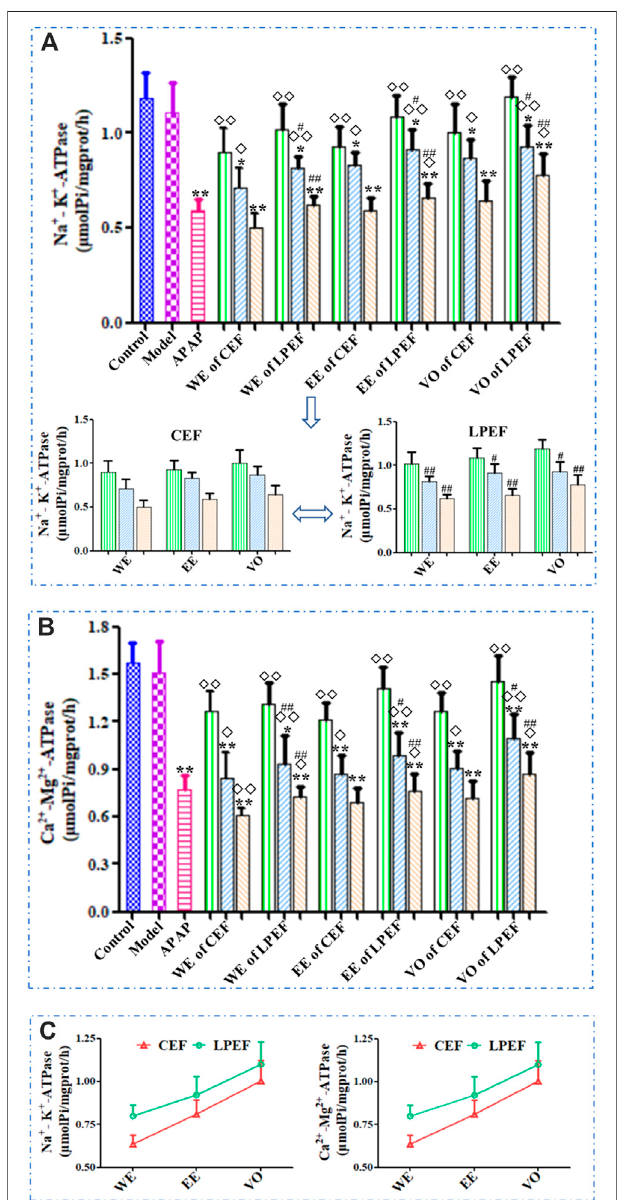
FIGURE 4 | Comparison of mitochondrial ATP enzyme activities in the liver of rats treated with different extracts. (A) Na + -K + -ATPase (upper: comparison between 21 groups; lower: magni fi ed comparison between CEF and LPEF). (B) Ca 2+ -Mg 2+ -ATPase and (C) changing trend of ATP enzyme activities between different extracts at high dose. Values are mean ± SD of 10 replicated samples; vs. control group, p < 0.05 ( * ) and p < 0.01 ( ** ); vs.CEF, p < 0.05( # )and p < 0.01( ## );vs.APAP, p < 0.05( ◇ )and p < 0.01( ◇◇